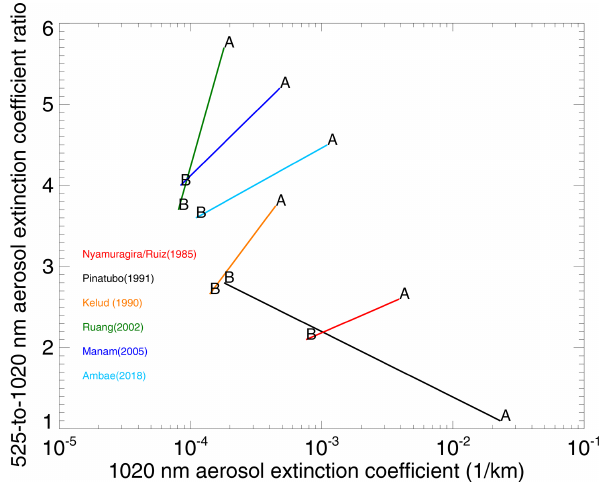
Figure 7. The 525-to-1020nm extinction ratio versus 1020nm ex- tinction ratio for several volcanic eruptions since 1990. The change in the aerosol extinction coefficient and extinction ratio for each vol- canic event is denoted by two points “B” and “A”, which represent the change in the extinction coefficient and extinction ratio before and after